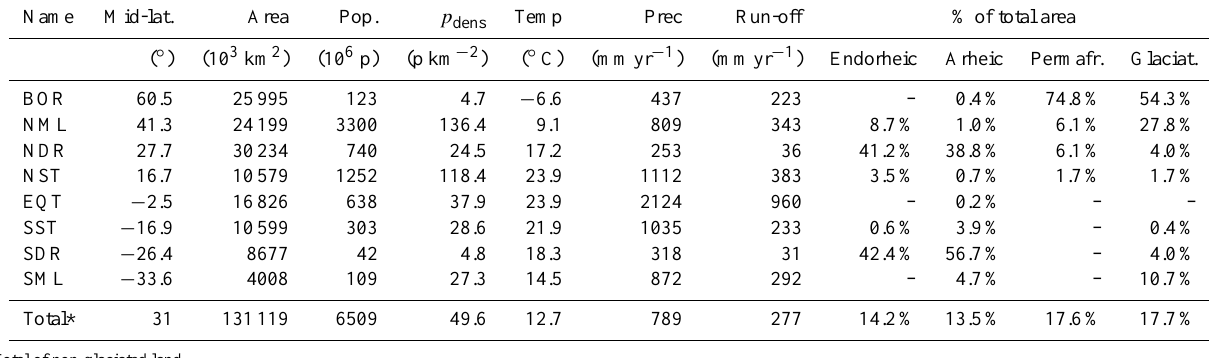
Table 3. General average characteristics of hydrobelts (cell averages, weighted averages and totals). BOR = boreal, NML = northern mid- latitude, NDR = northern dry, NST = northern subtropical, EQT = equatorial belts and SML, SDR, SST their southern analogues (see Fig. 2 for their spatial distributions and Table 2 for data sources).